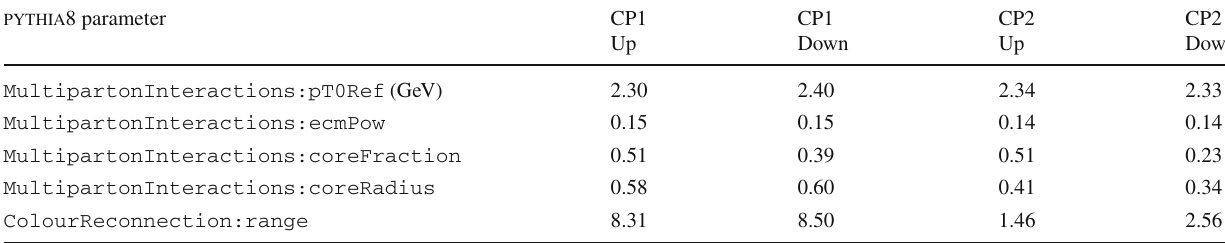
Table 6 Parameters of the “up-” and “down-” variation eigentunes for the pythia 8 CP1, and CP2 tunes